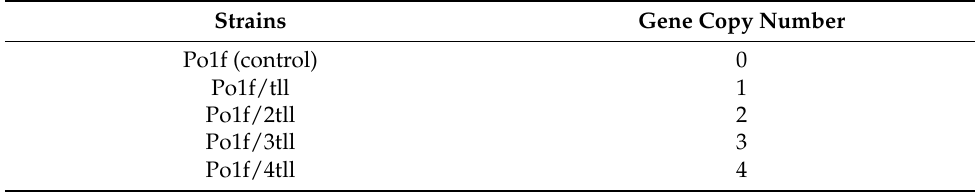
Table 1. Recombinant strains with different copy numbers of the tll gene. Strains Gene Copy Number